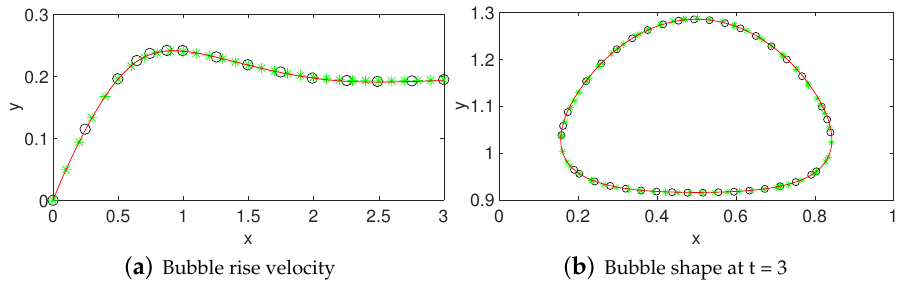
Figure A2. Verification test: Rise velocity and bubble shape for test case 1 of Hysing et al. [33] (o) TP2D [33], (*) VOF S (this work), (–) FT S (this work).